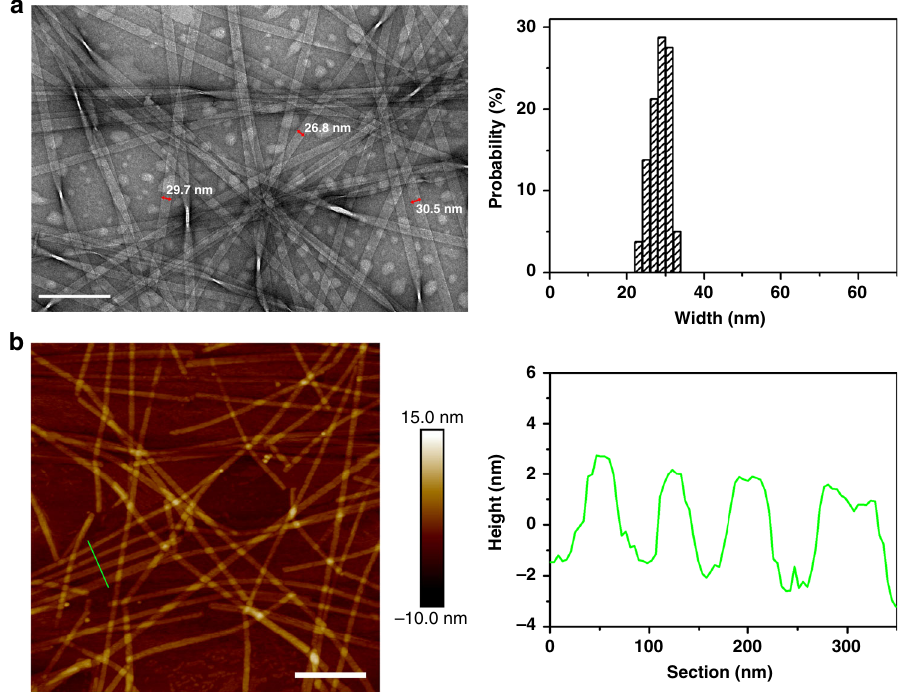
Fig. 4 Nanoribbons formed by 8 mM Ac-I 3 SGK-NH 2 at pH 7.0 after incubation for 1 week. a TEM micrograph (left panel) and width distribution histogram (right panel, based on measurements of ~100 nanoribbons). Scale bar, 200 nm. b Tapping-mode height AFM image (left panel) and representative cross- sectional pro fi le (right panel). Scale bar, 500